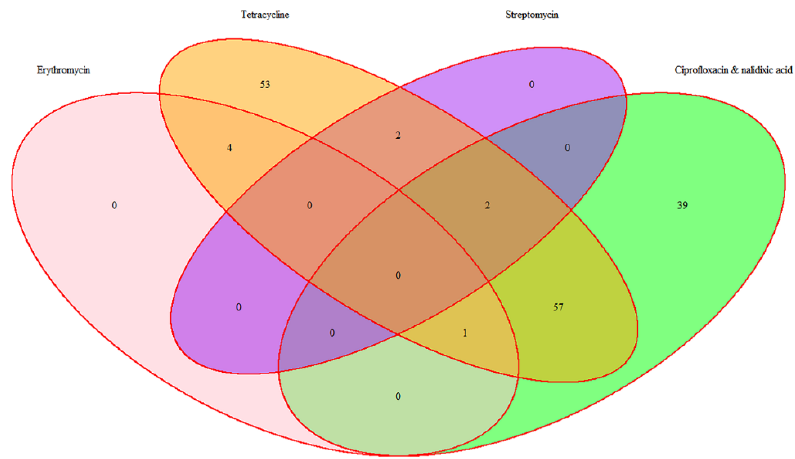
Figure 2. Distribution of antimicrobial resistance among 158 thermophilic Campylobacter spp.